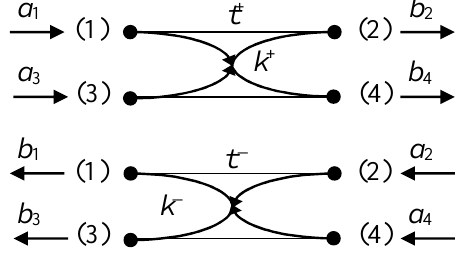
Fig. 2. Signal flow-graph of the directional coupler, in the general case. Input/output fields at port p are denoted ( a p , b p